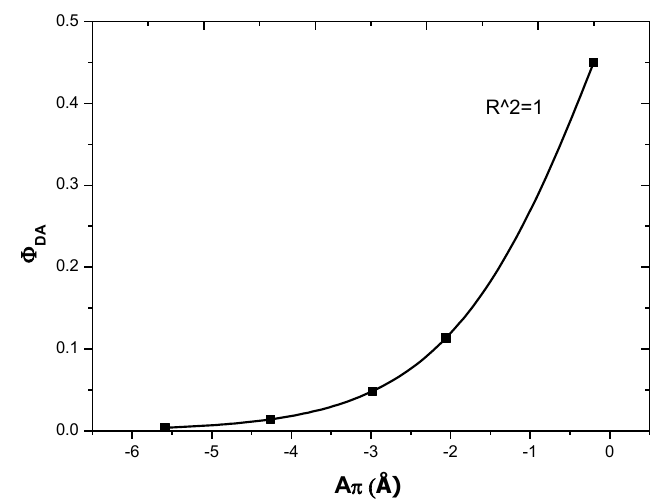
Φ DA and A π in 0-D Cs 4 PbBr 6